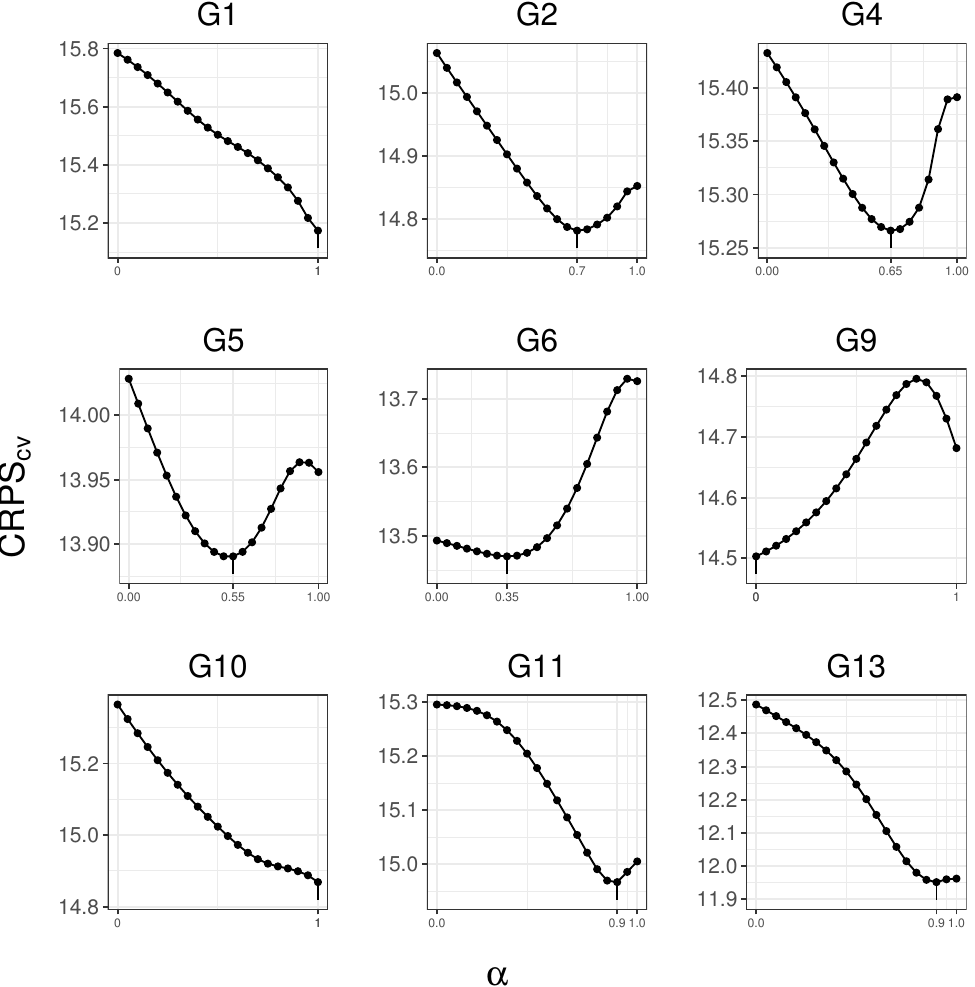
Figure 5. Computed values of CRPS cv ( α ) defined as in Equation (16) and the selected optimal correction rate α for select grid cells and for future period 1 (2021–2060) under SSP3